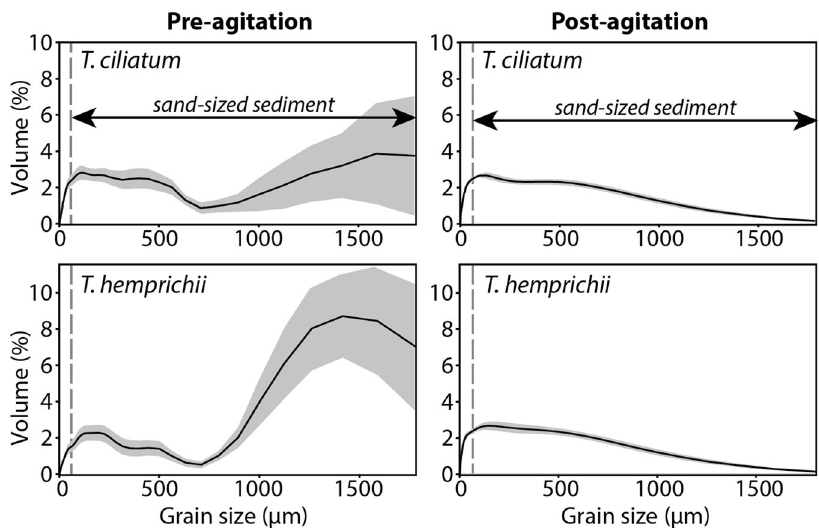
Fig. 4 Sediment grain size distributions pre- and post- agitation. Species-speci fi c sediment grain size distributions pre- and post- 21 days continuous agitation. Sediment to the right of the dashed grey line is sand-sized (63 – 2000 µ m). Grey shading represents the standard